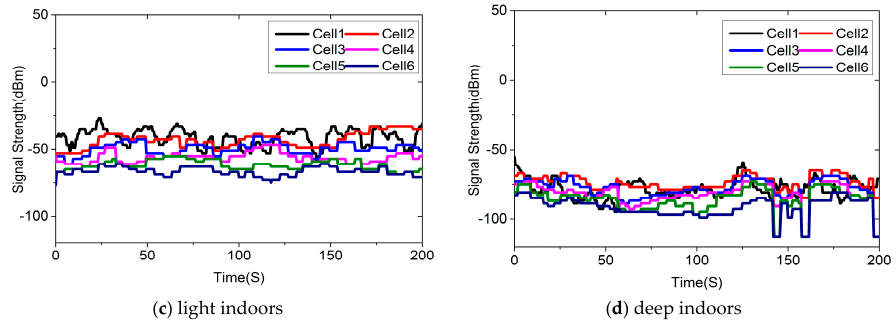
Figure 6. Six cellular base stations’ signal strength received in different environments.